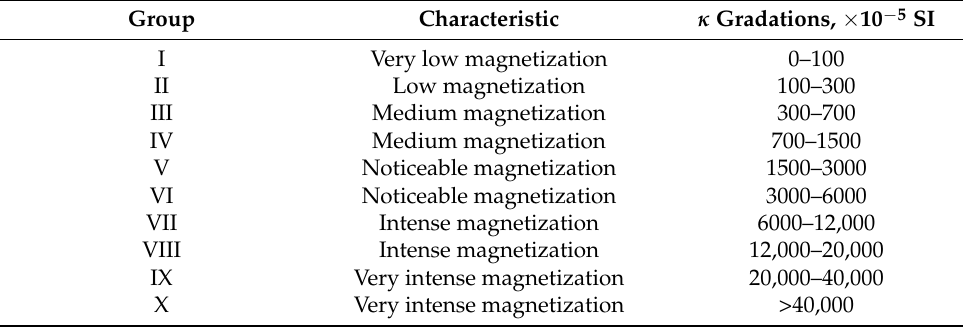
Table 1. Gradation scale for substances by magnetic susceptibility. Reprinted/adapted with permis- sion from Ref. [10], 1984, Avchyan,